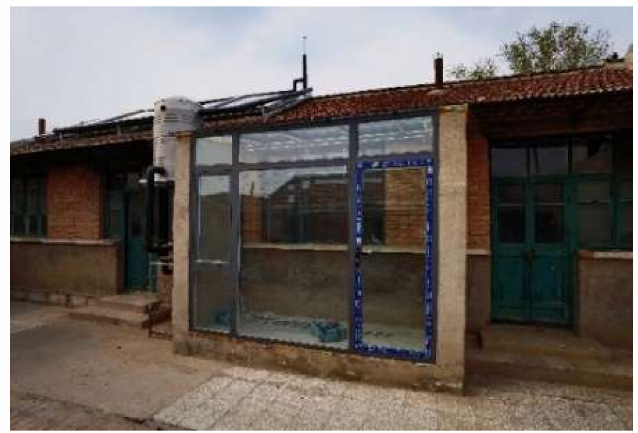
Figure 3. Real view of the farmhouse with attached